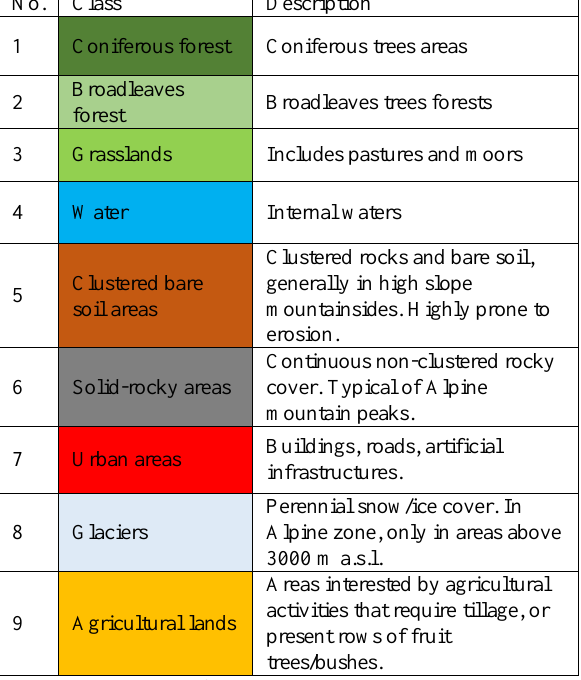
Table 3. Classes of Land Cover considered in this